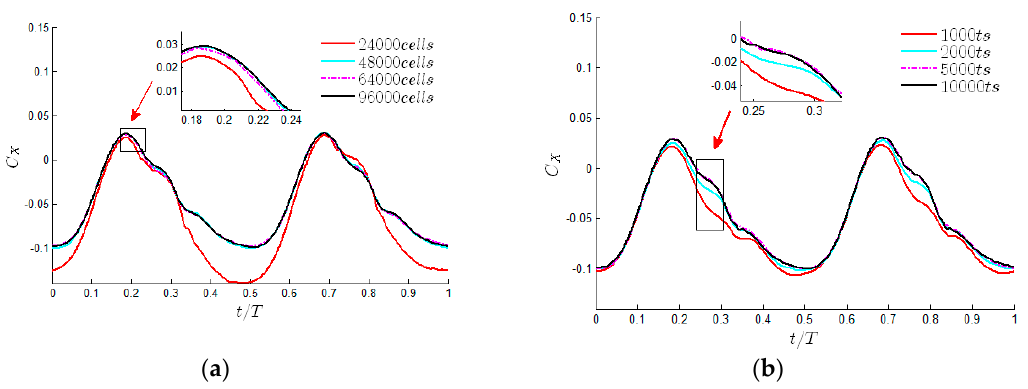
Figure 5. Evolution of the thrust coefficient for ( a ) the mesh independence study and ( b ) the time-step independence study for 𝑦 (cid:2868) = 0.2 , 𝑘 ∗ = 0.09 , and 𝑓 ∗ = 0.17 . Table 1. Mesh and time-step independence results.